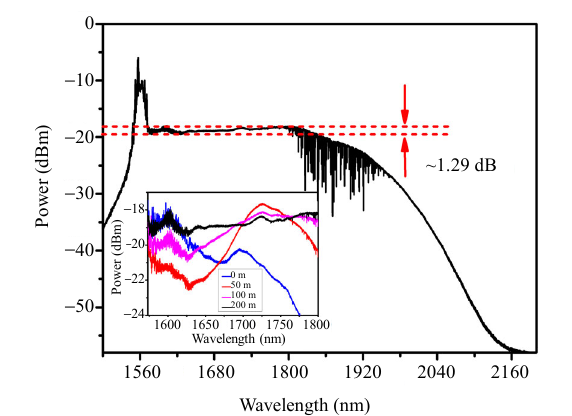
Fig. 7 Spectral distribution after the ZBLAN fiber when a 200-m-long SMF is connected. Insert: the comparison of spectral distribution when different lengths of the SMF are